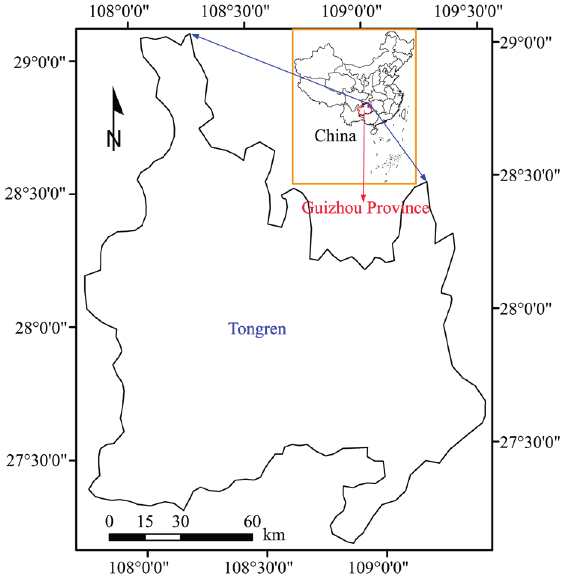
Figure 1 - Map of the study